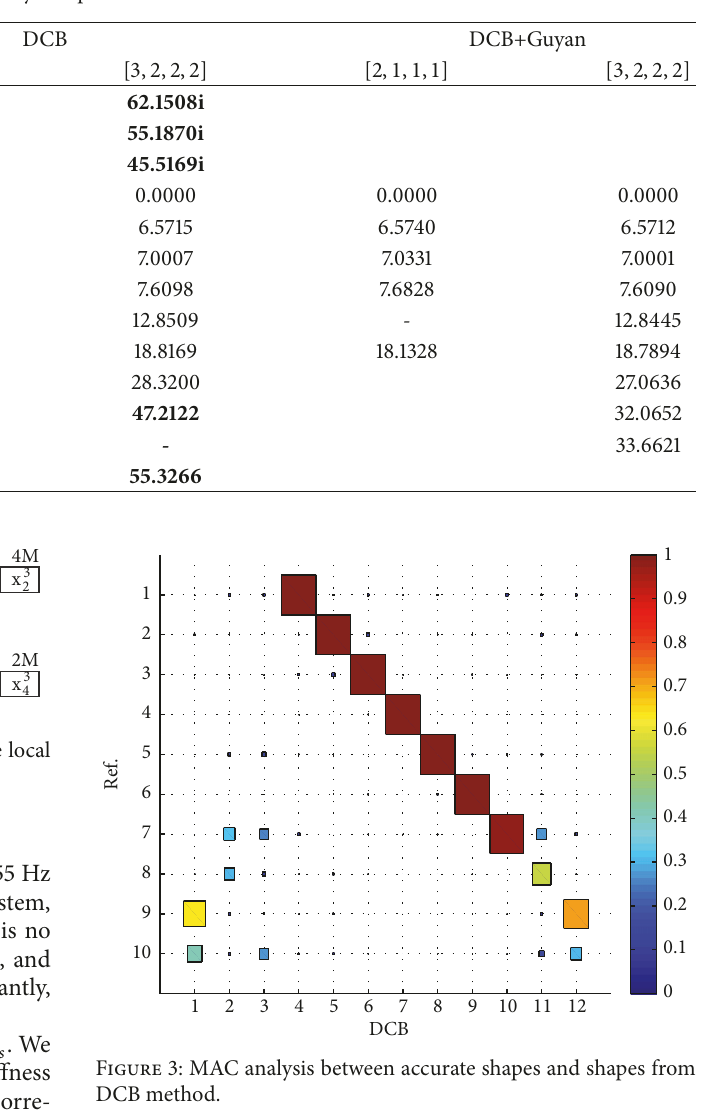
Table 1: The mode frequency comparison in different methods /Hz.